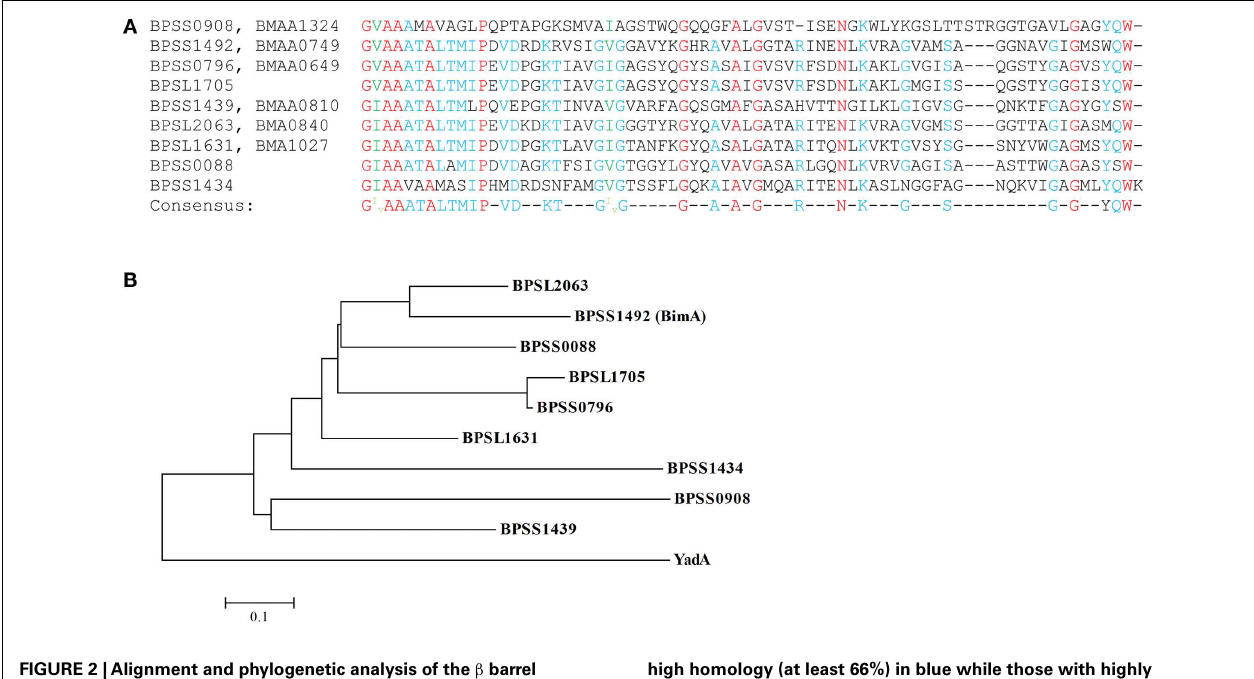
FIGURE 2 |Alignment and phylogenetic analysis of the β barrel domains of the putative B. pseudomallei and B. mallei TAAs: (A) the nine B. pseudomallei C-terminal 70–72 aa β barrel domains ( B. mallei homologs 100% identical at this region) were aligned; identical residues are highlighted in red, those with